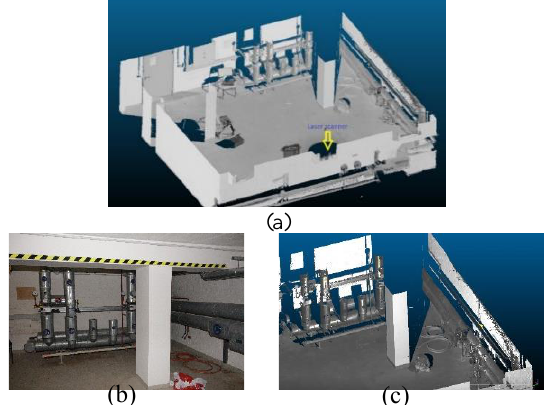
Figure 3. Test data set: (a) 3D point cloud, (b) camera image of AOI, (c) 3D point cloud of